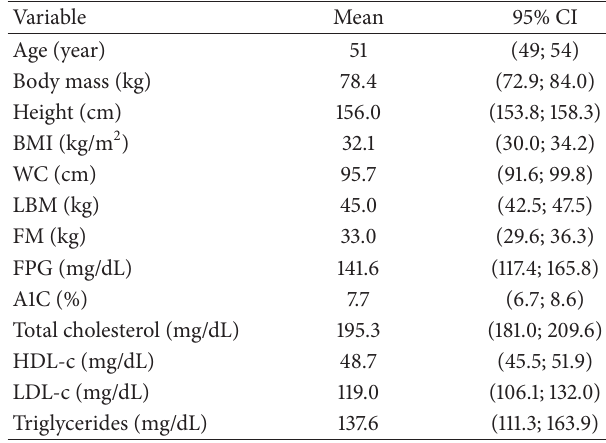
Table 2: Characteristics of women with type 2 diabetes